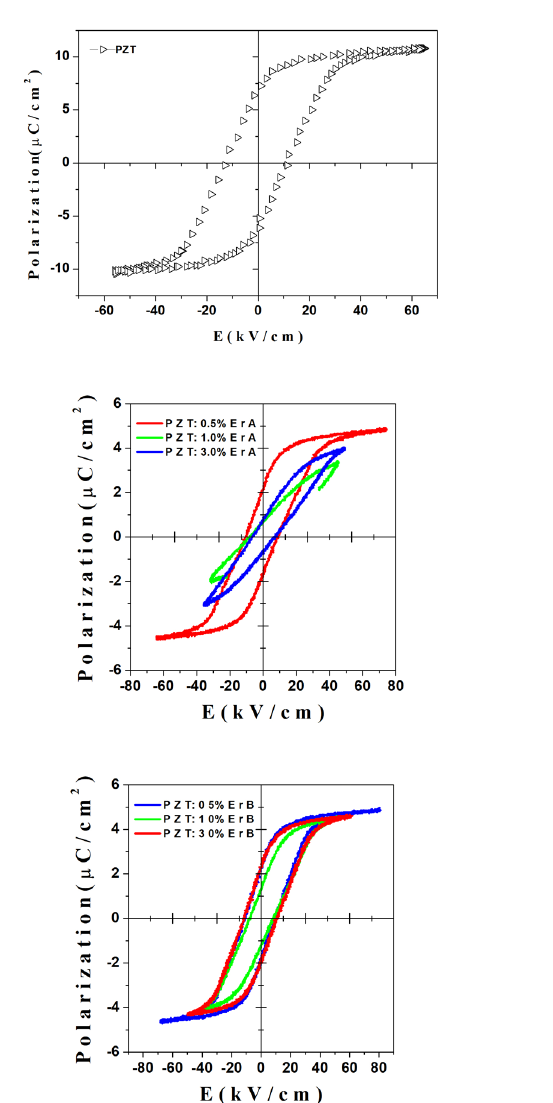
Figure 14. Hysteresis loops at room temperature for all